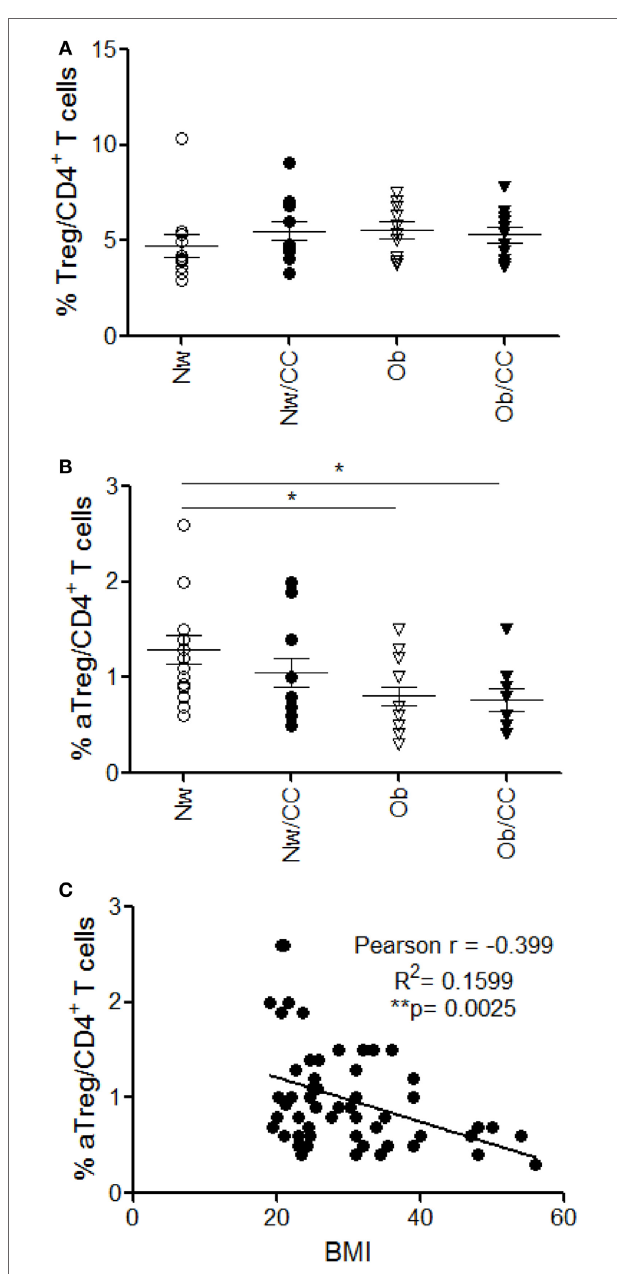
FigUre 2 | A significant reduction of circulating CD45RA − FOXP3 hi activated T reg (aT reg ) cells occurs in obese (Ob) subjects: correlation with body mass index (BMI). Peripheral blood (PB) lymphocytes isolated from lean normal weight (Nw), Ob, lean affected by colorectal cancer (CRC) (Nw/CC), and Ob affected by CRC (Ob/CC) donors were analyzed by flow cytometry. Frequency of regulatory T (T reg ) (CD4 + FOXP3 + CD127 low ) cells (a) and aT reg cells (CD4 + FOXP3 high CD45RA − ) (B) was estimated in PB of the four groups. Each dot represents an individual donor. Mean ± SEM is shown for each group. * p < 0.05 by analysis of variance. ( c) Pearson’s correlation ( r ) between aT reg cell frequency and BMI in all subjects (** p <